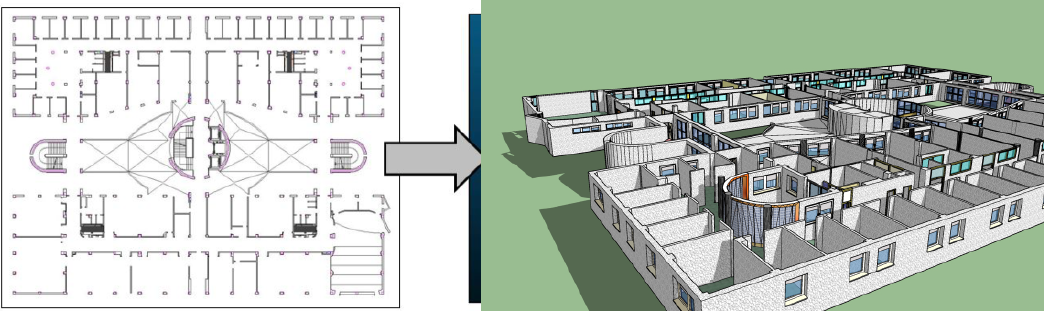
Figure 2. The resulting 3D model from 2D CAD